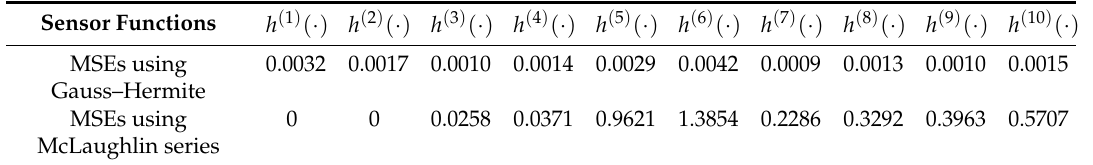
Table 1. Mean square